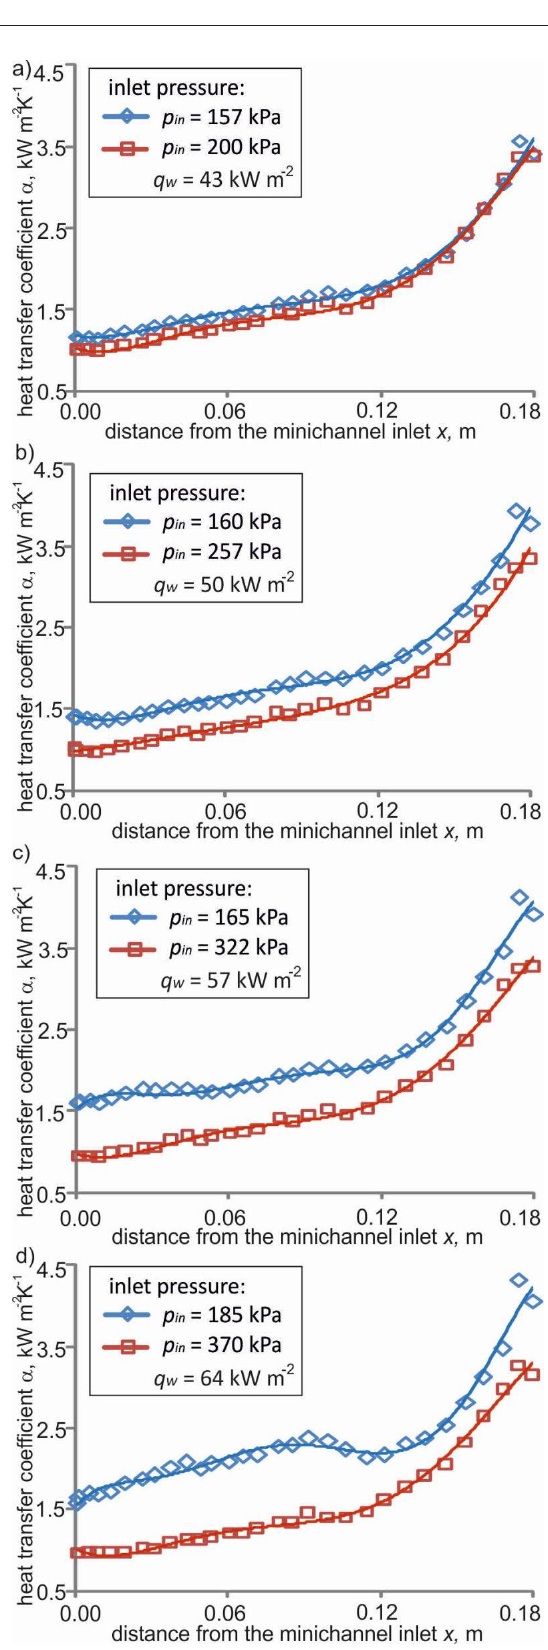
Fig. 3. Heat transfer coefficient vs. distance from the minichannel length obtained for the subcooled boiling region at various inlet